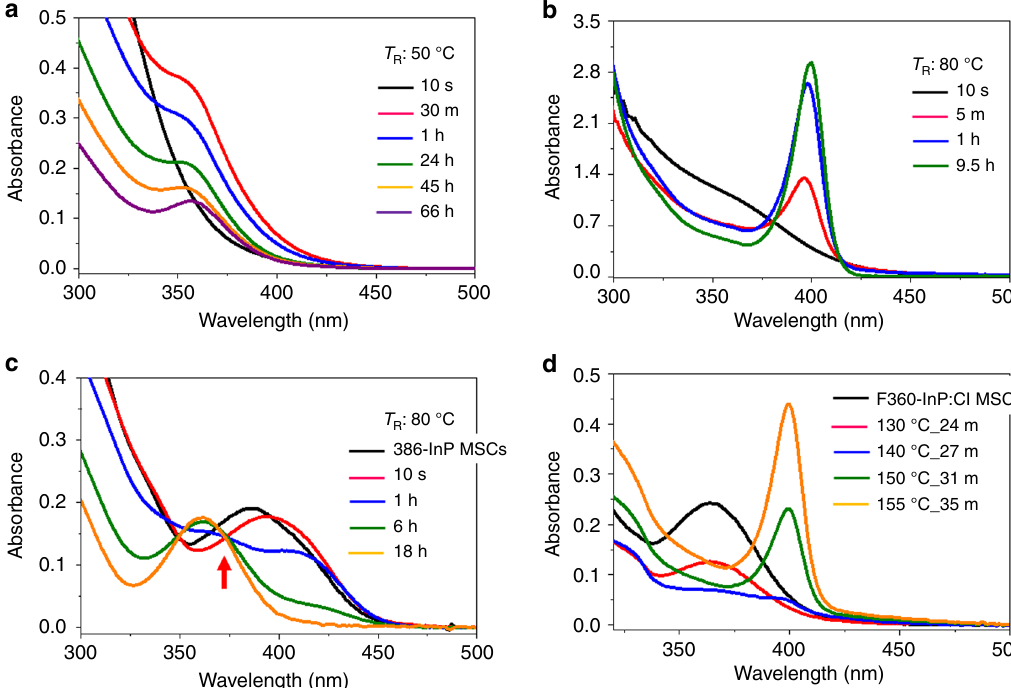
Fig. 2 Syntheses of F360-InP:Cl MSCs and F399-InP:Cl MSCs. UV – vis absorption spectra of aliquots taken over time during a direct synthesis of F360- InP:Cl MSCs from In(Ac) 3 , HMA, InCl 3 , and (TMS) 3 P at 50 °C. The molar ratio of In(Ac) 3 , HMA, to InCl 3 is 1:3:0.6. b Direct synthesis of F399-InP:Cl MSCs from In(Ac) 3 , InCl 3 , HMA, and (TMS) 3 P at 80 °C. The molar ratio of In(Ac) 3 , HMA to InCl 3 is 1:3:1. c Conversion synthesis of F360-InP:Cl MSCs from as- synthesized 386-MA InP MSCs using 56 equivalents of InCl 3 at 80 °C. (Red arrow: isosbestic point) d Conversion synthesis of F399-InP:Cl MSCs from F360-InP:Cl MSCs by heating.